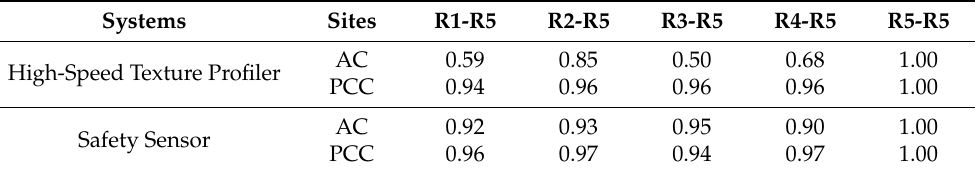
Table 2. Correlation coefficients of repeated runs. Systems